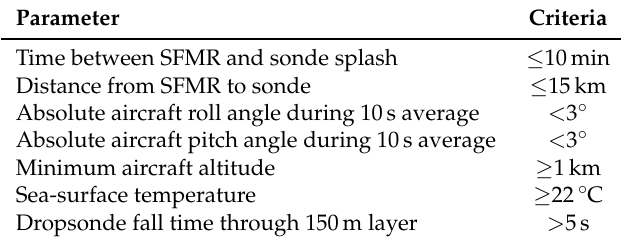
Dropsonde fall time through 150m